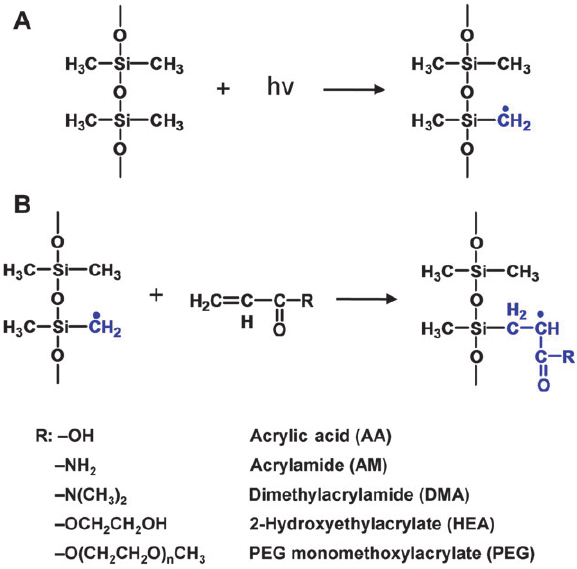
Figure 4 Reaction mechanism of UV graft-polymerization onto the PDMS surface. Step (A) shows the formation of radicals on the PDMS surface via UV irradiation. Step (B) shows the initiation of the polymerization reaction. R is the monomer side group (Hu et al. 2002